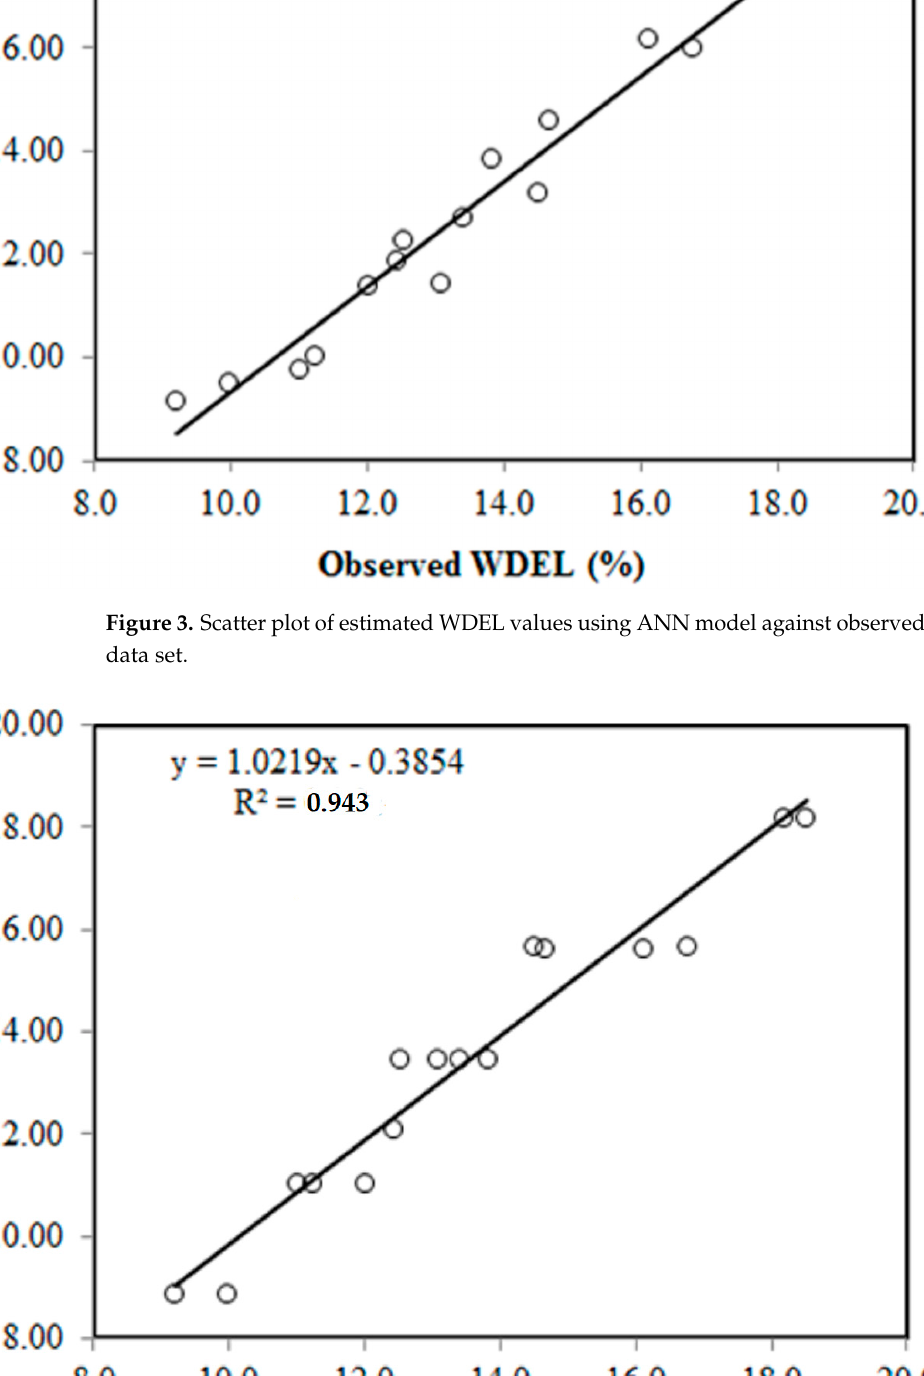
Figure 4. Scatter plot of estimated WDEL values using REPTree model against observed values of testing data set.